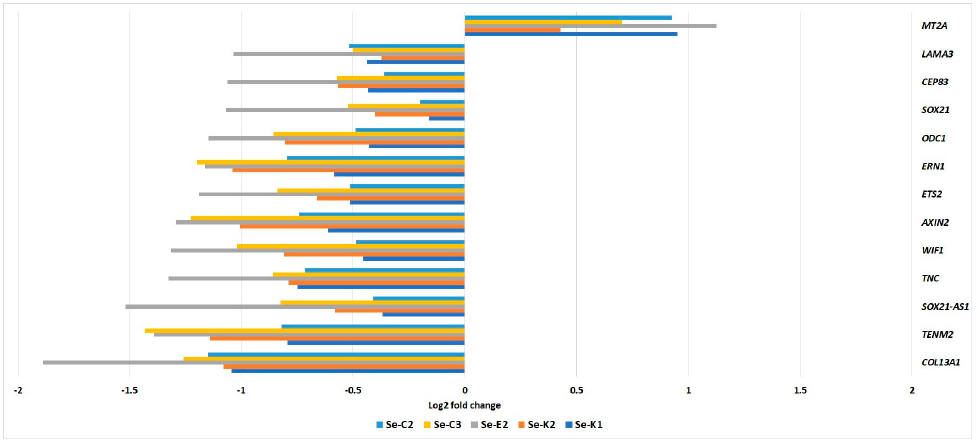
Figure 3. Transcriptome analysis in Colo 320 cells after Se-K1, Se-K2, Se-E2, Se-C2, and Se-C3 treat- ment. Names of the genes in brackets: MT2A (metallothionein 2A), LAMA3 (laminin, alpha